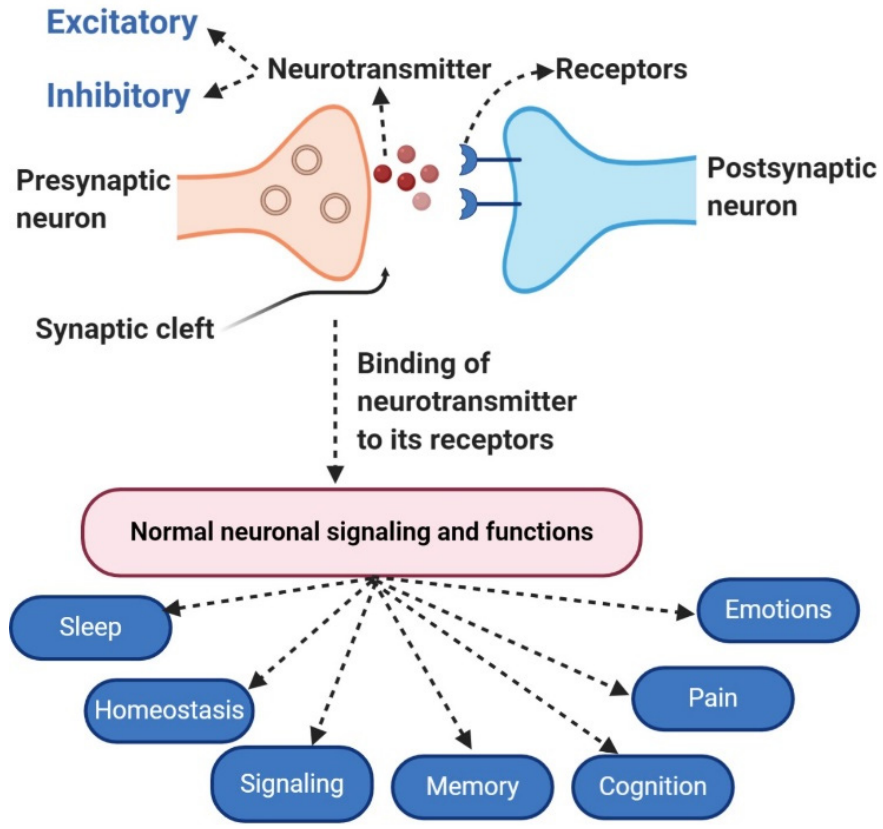
Figure 1. The diagram shows the basic mechanism of neurotransmission. NTs of both types (inhibitory and excitatory) are released from synaptic vesicles in synapses into the synaptic cleft. In the synaptic cleft, NTs are received by receptors present on the target cell. After binding with receptors, NTs provide signaling for various functions including sleep, homeostasis, pain, emotion, and cognition.